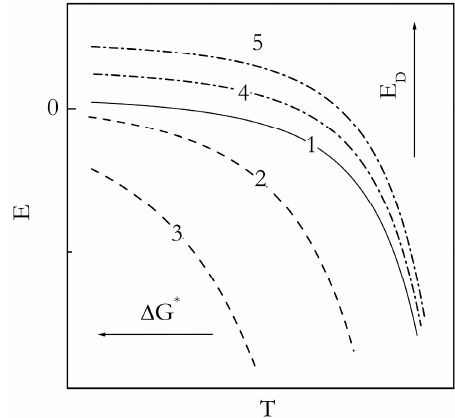
Figure 11. Schematic representation of the effect of the parameters of the Turnbull-Fisher equation (Equation (1)) on the temperature dependence of the activation energy (Equation (2)). Arrows show the direction of increase in Δ G * and E D . Curves 2 and 3 have the same E D as 1, but consecutively increasing values of Δ G *. Curves 4 and 5 have the same Δ G * as 1, but consecutively increasing values of E D .